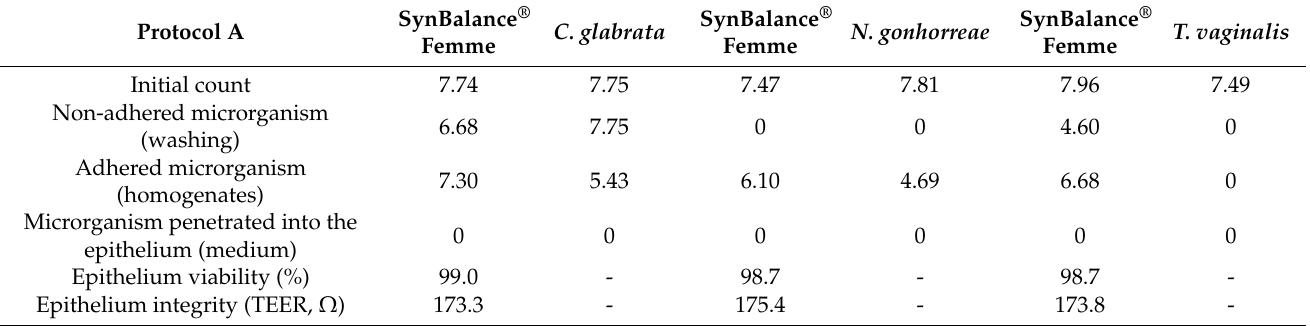
Table 1. In vitro model of antimicrobial efficacy of SynBalance ® Femme vs. C. glabrata ATCC 15126, N. gonhorreae ATCC 43069 or T. vaginalis ATCC 30238 on HVE. The amount of SynBalance ® Femme and each pathogen was expressed as log 10 CFU/mL. The epithelium viability was expressed in percentage, while the TEER in Ohm × cm 2 . All the experiments were carried out in